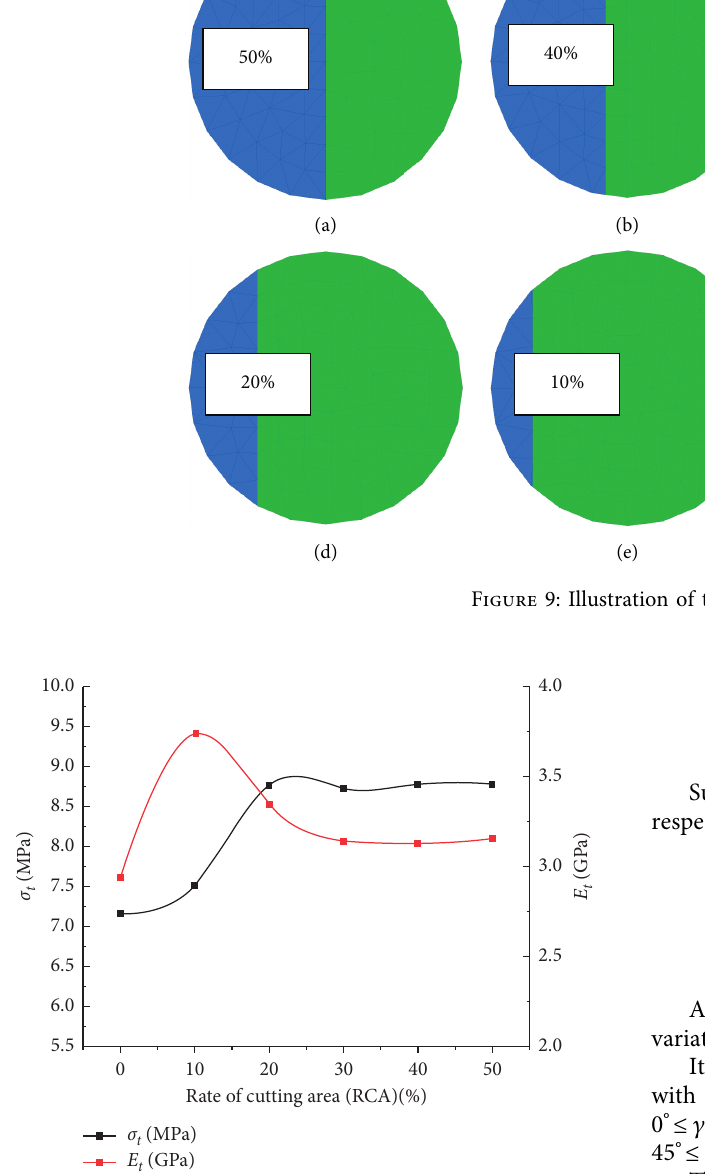
Figure 10: Change in mechanical behavior under different